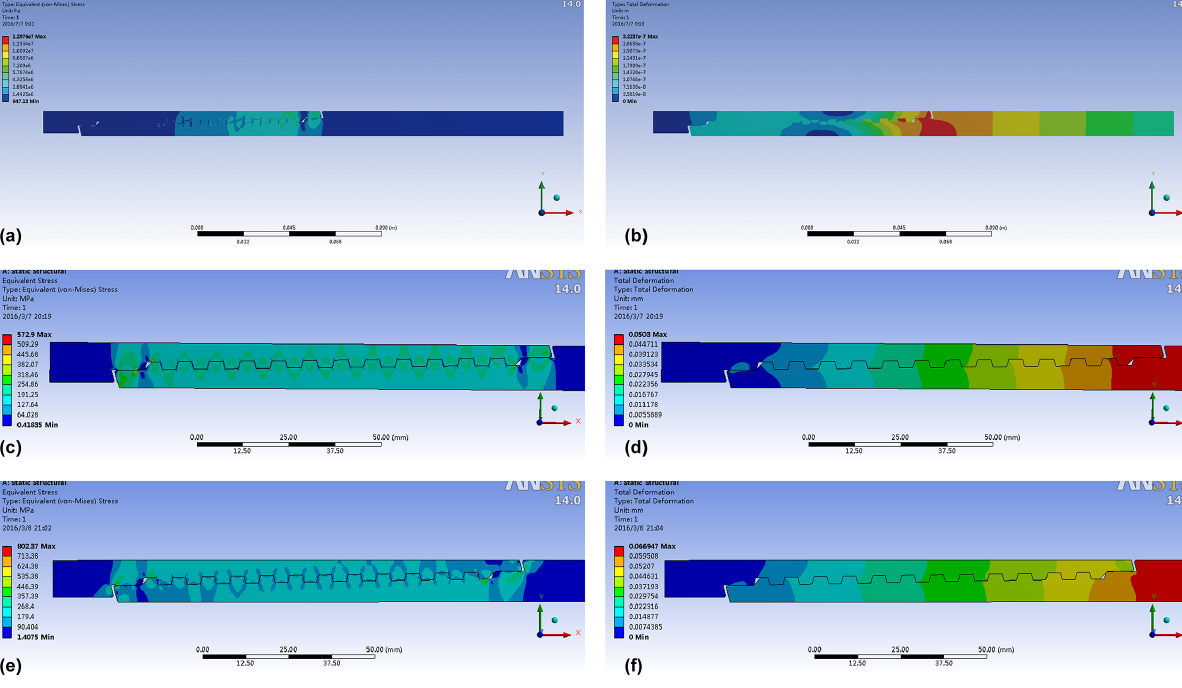
Figure 8. Joint stress and strain under allowable tension force: (a) joint stress in state A , (b) joint strain in state A , (c) joint stress in state B , (d) joint strain in state B , (e) joint stress in state C and (f) joint strain in state C